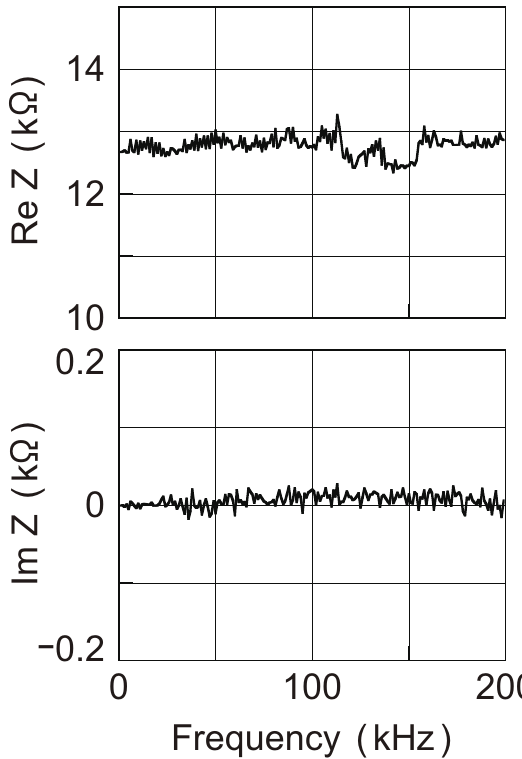
Figure 6. Impedance spectra Z ( ω ) of a single-atom contact of Au. Upper and lower panels represent Re Z ( ω ) and Im Z ( ω ) , respectively. Both parts show a flat spectrum up to 200 kHz and Re Z ( ω ) ∼ 1/ G 0 and Im Z ( ω ) ∼ 0. Reproduced from [57], copyright (2010) The Japan Society of Applied